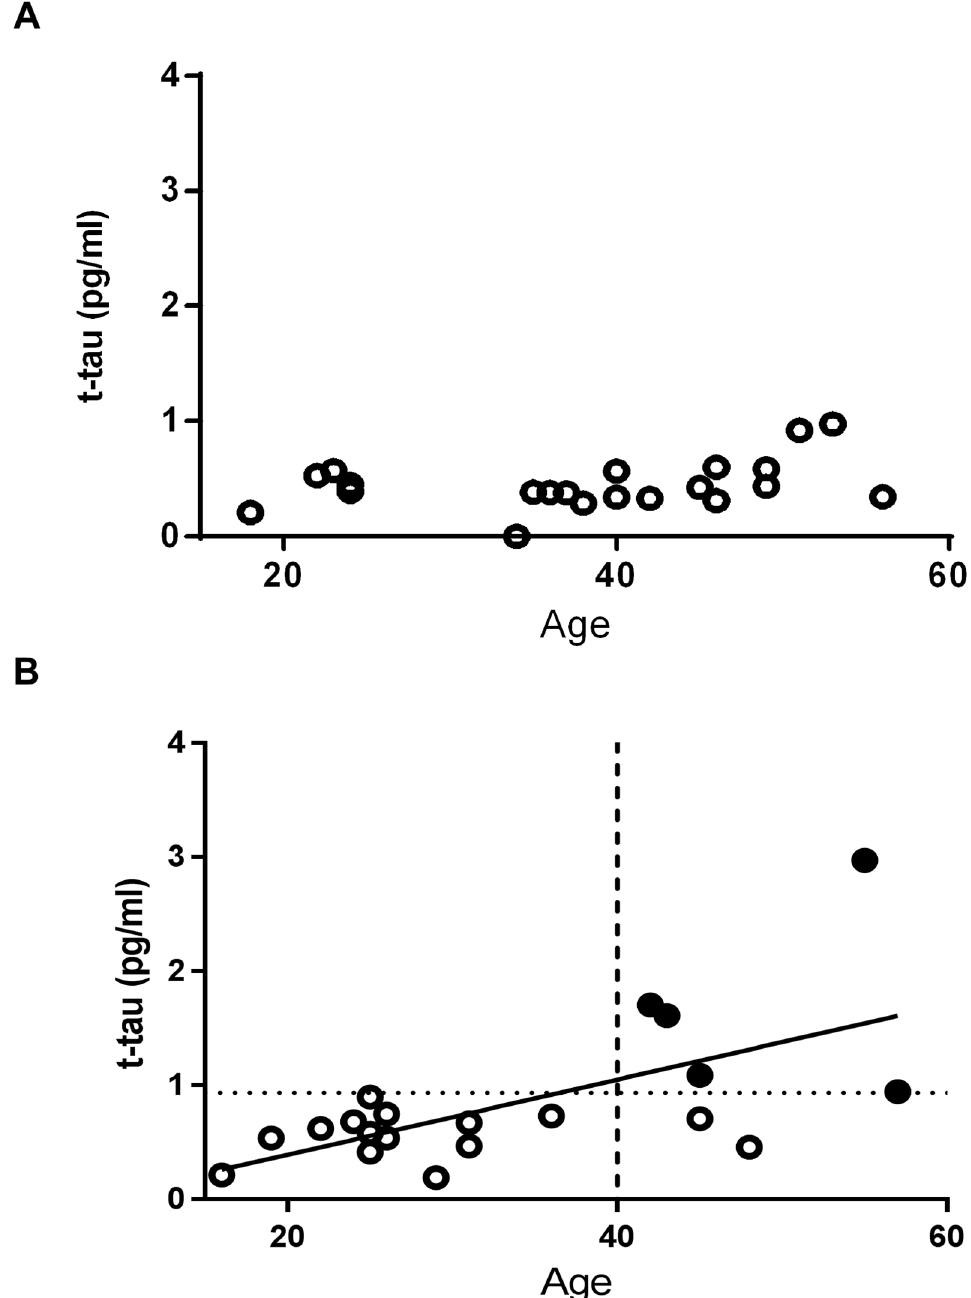
Fig 2. (A) Correlationbetweent-tau levels and age in the control group. There was no significantrelationship. The P-value obtainedfrom Spearman’srank correlation coefficient test was 0.420. (B) Correlation betweent-tau levels and ages in the DS group. A significantpositive relationshipwas found (P = 0.022). Filled circles (black) indicatethe DS cases with t-tau levels exceedingthe cut-off value (0.934 pg/ml indicatedby a dotted horizontal line), estimated from the control group. A dashedvertical line has been drawn to indicate the positionof 40 years of age.